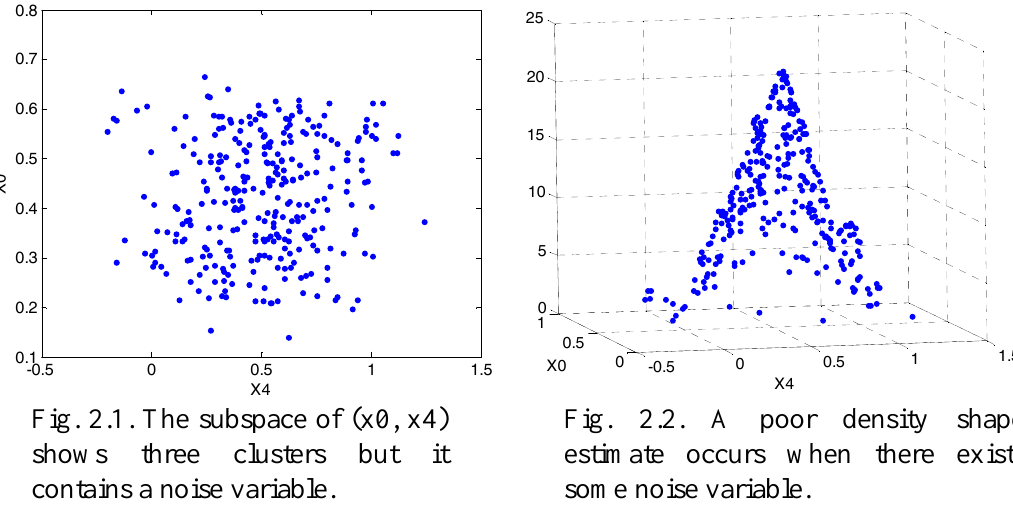
Fig. 2.2. A poor density shape estimate occurs when there exists some noise